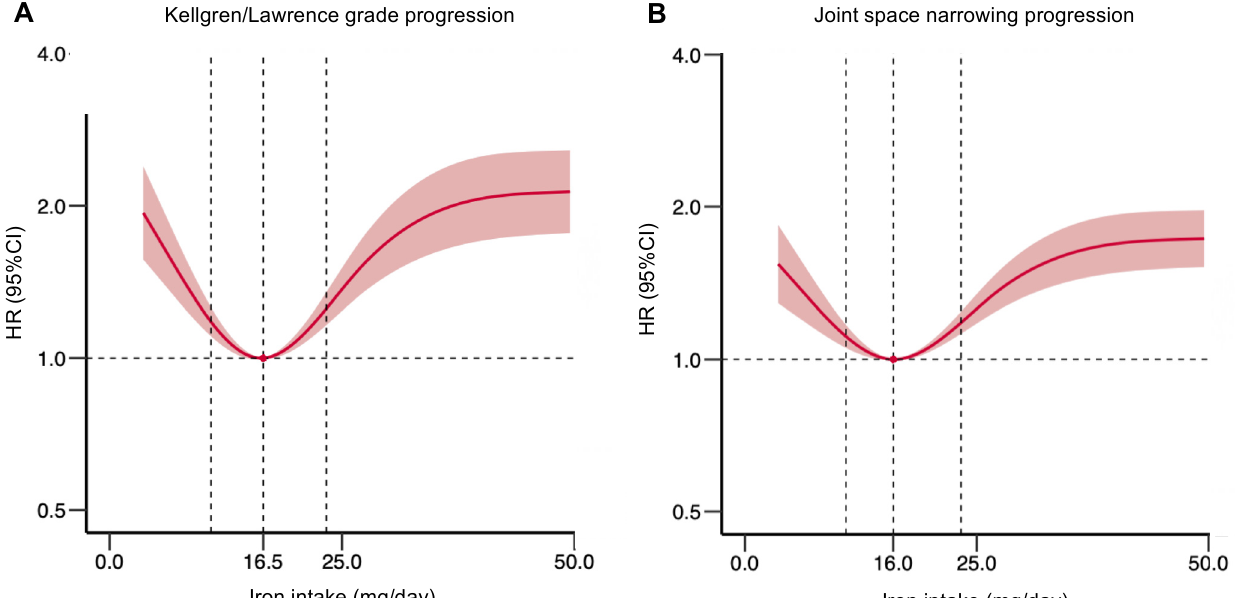
Figure 2. Relation of iron intake to risk of ( A ) KL-grade and ( B ) JSN-score progression. Dashed vertical lines represent inflection points and relative minimal risk thresholds of 10.9 mg/day and 23.3 mg/day (Deciles 3–5). Estimates adjusted for age, sex, BMI, PASE score, NSAID use, baseline KL grade, baseline JSN score, mineral intake (iron, sodium, potassium, calcium, zinc, and magnesium), as well as intake of other main nutrients (calories, fat, carbohydrate, and protein). The p values for overall association and the p values for nonlinearity were less than 0.05 for all outcomes. HR = hazard ratio.